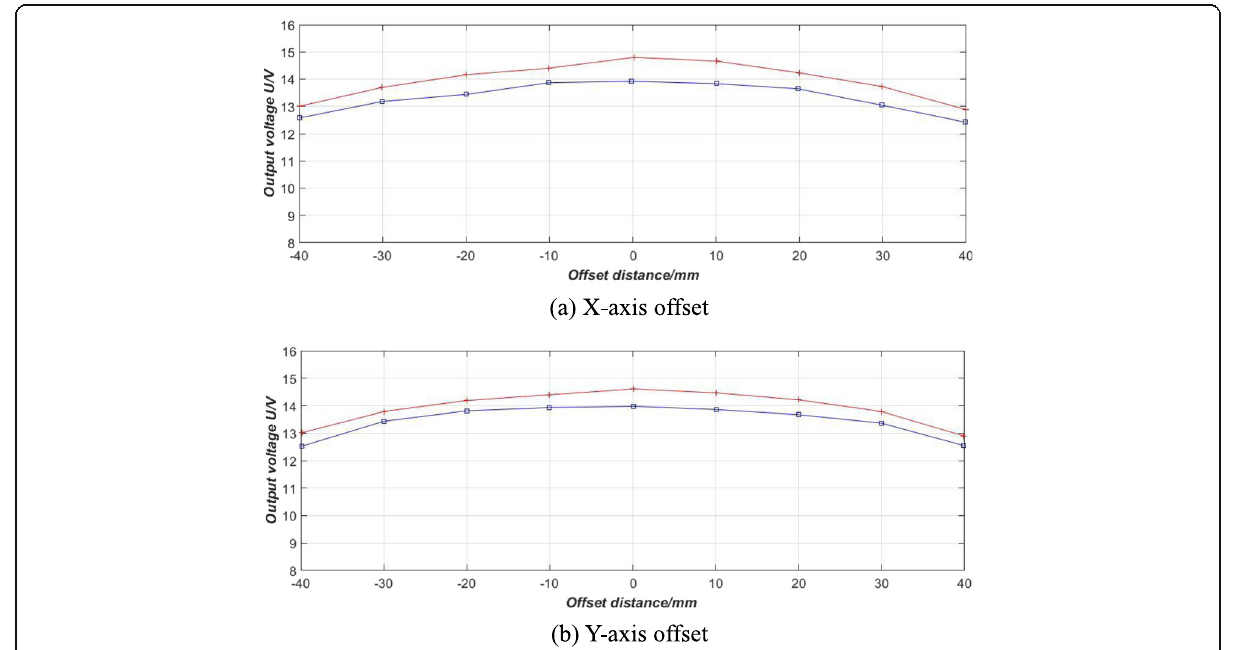
Fig. 17 System output voltage variation diagram at offset. a X -axis offset. b Y -axis offset